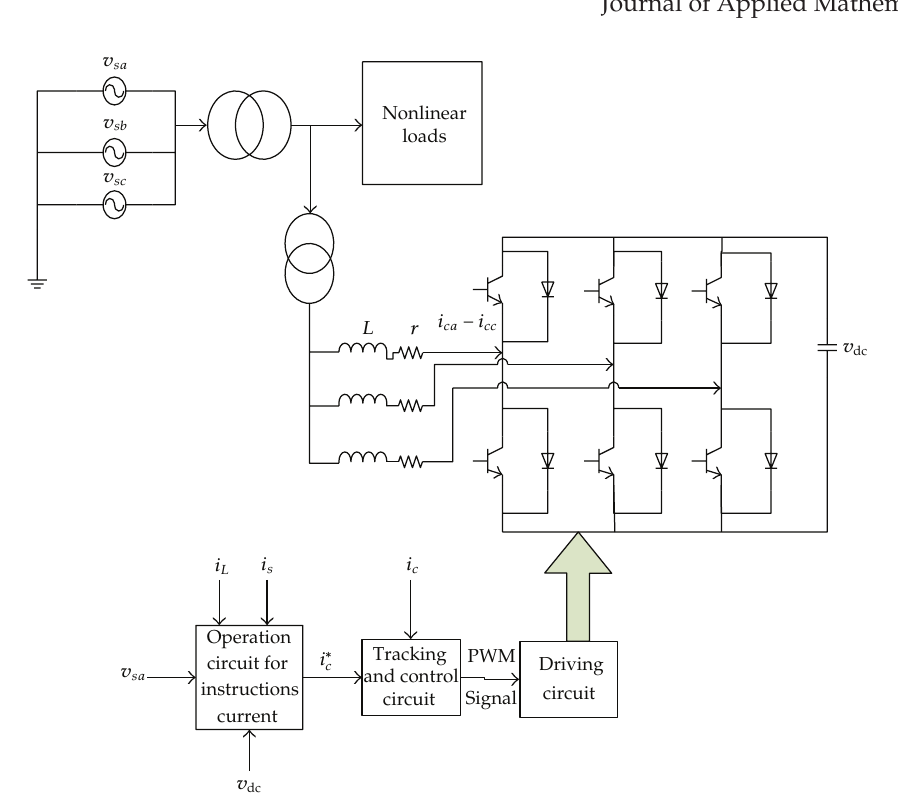
Figure 1: Block diagram for main circuit of